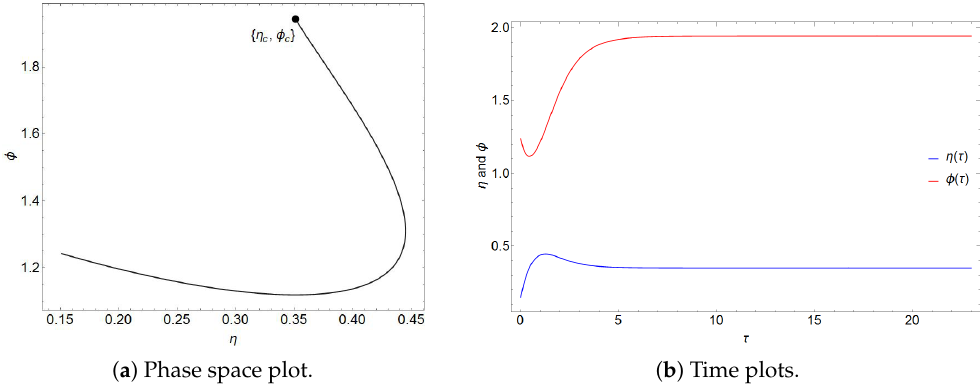
( a ) Phase space plot. ( b ) Time plots. Figure 2. Phase space plot with initial conditions η ( 0 ) = 0.15 and φ ( 0 ) =